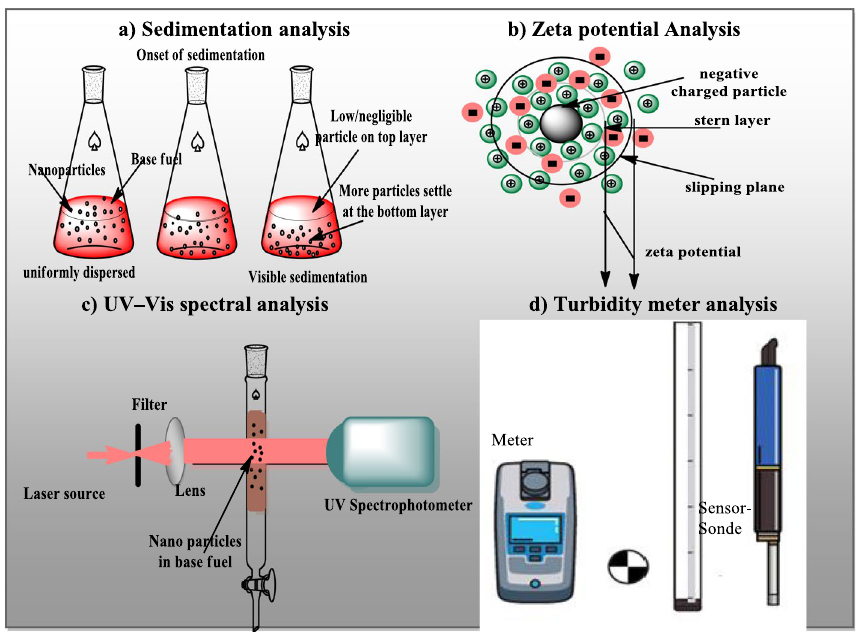
Fig. 8 Techniques for finding the stability of magnetite